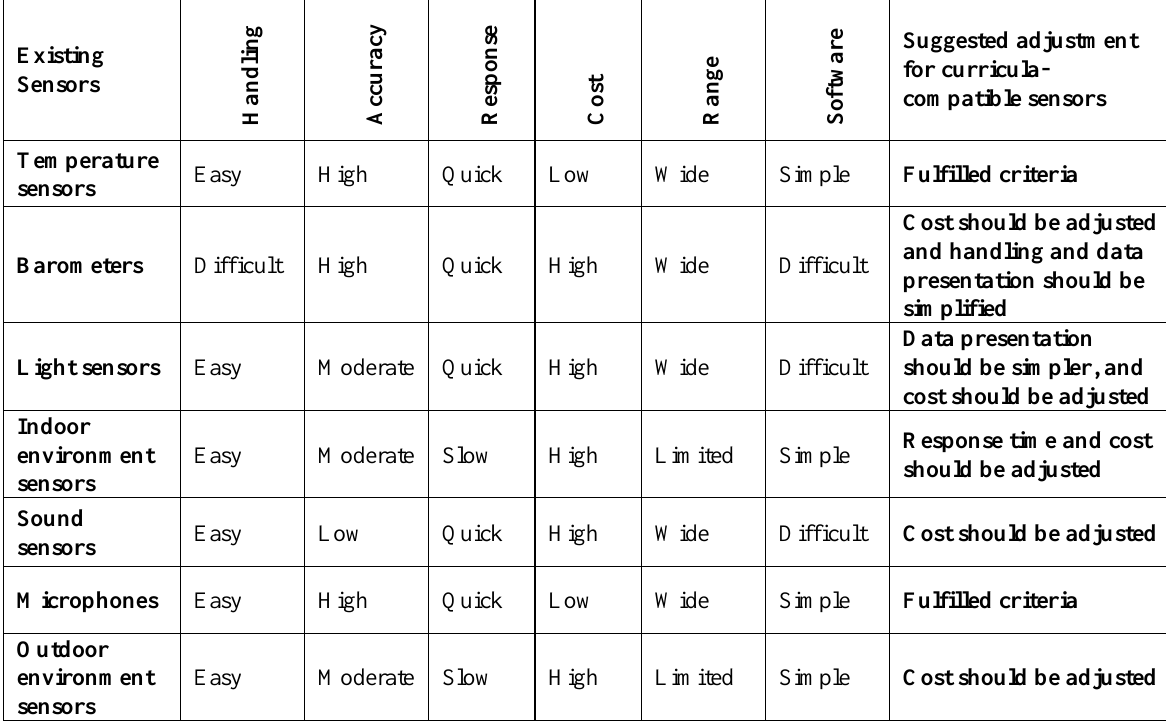
Table 4. Matching attribute criteria for curricula-compatible sensors with sensors (sensor classes) already available in the